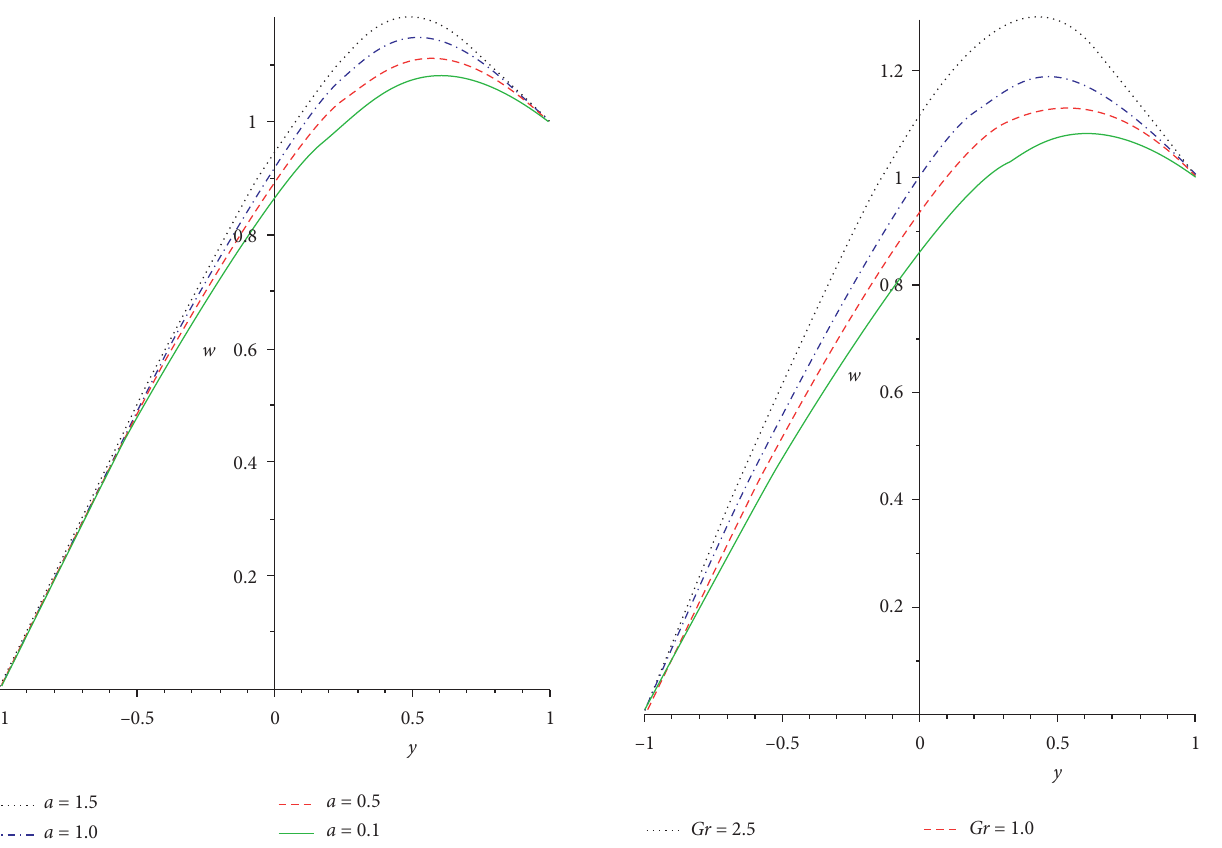
Figure 2: Velocity profile for rising values of a